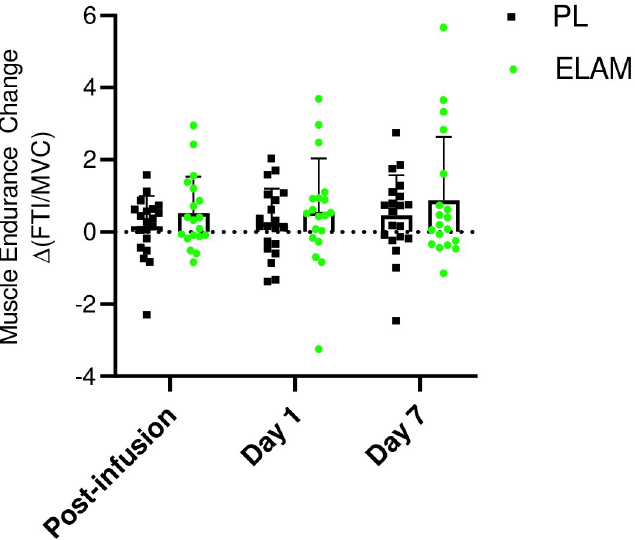
Fig 4. Change in muscle endurance test ( Δ FTI/MVC) with ELAM treatment. Change from baseline with ELAM treatment post-infusion, from baseline 1 day post-infusion (day 1) and from baseline 7 days post-infusion (day 7). Error bars show SD. ELAM = elamipretide; PL =